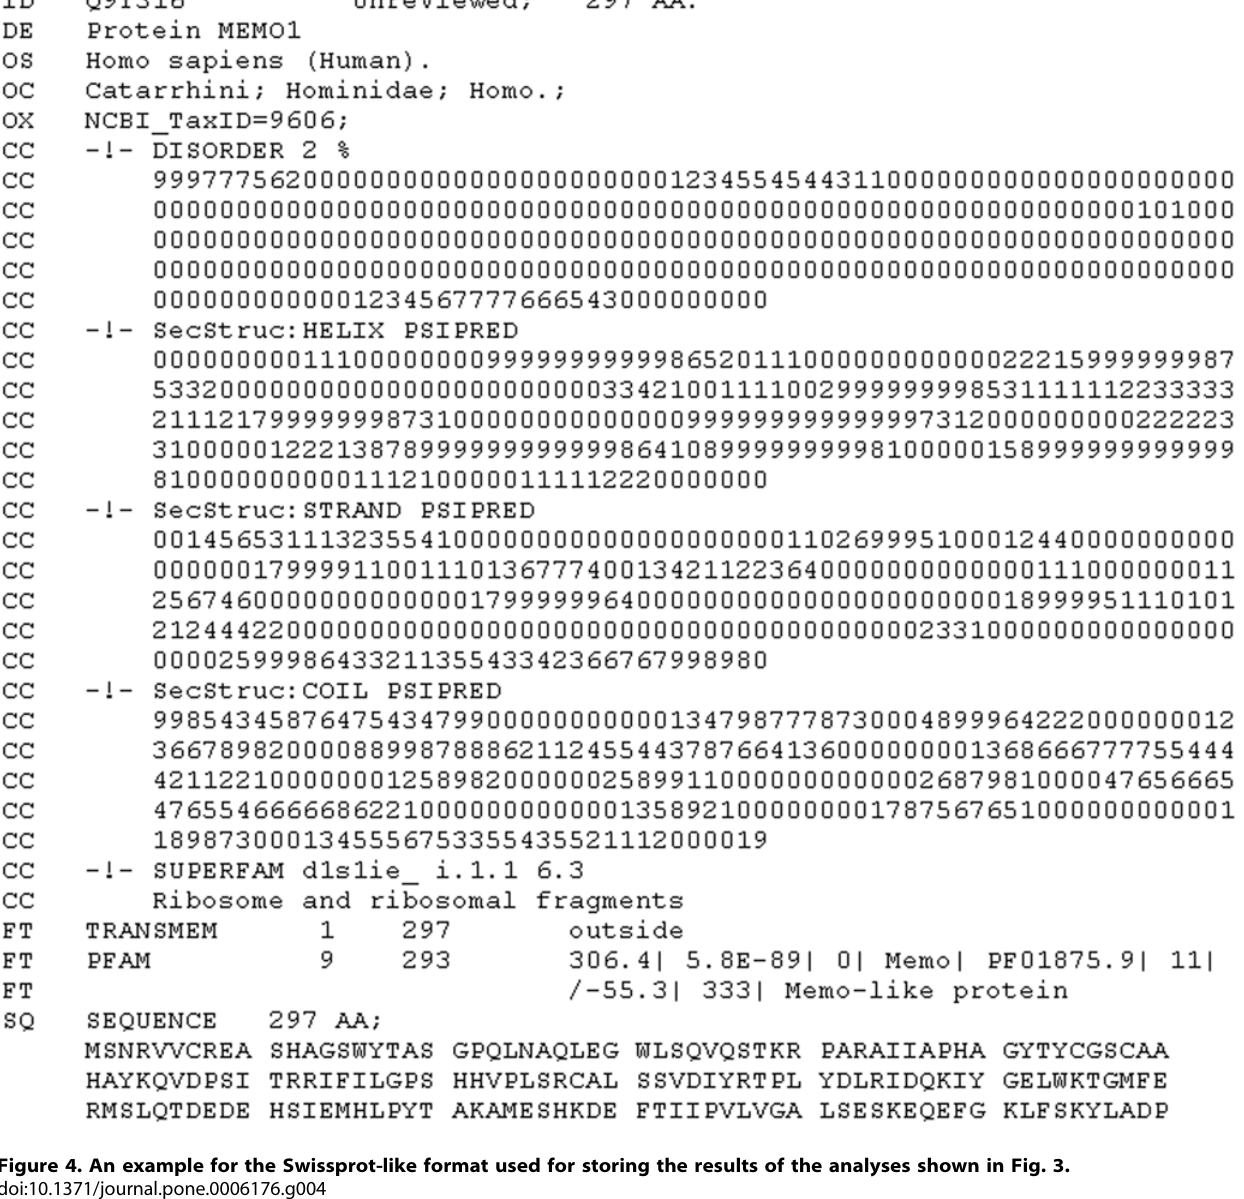
Figure 4. An example for the Swissprot-like format used for storing the results of the analyses shown in Fig. 3.